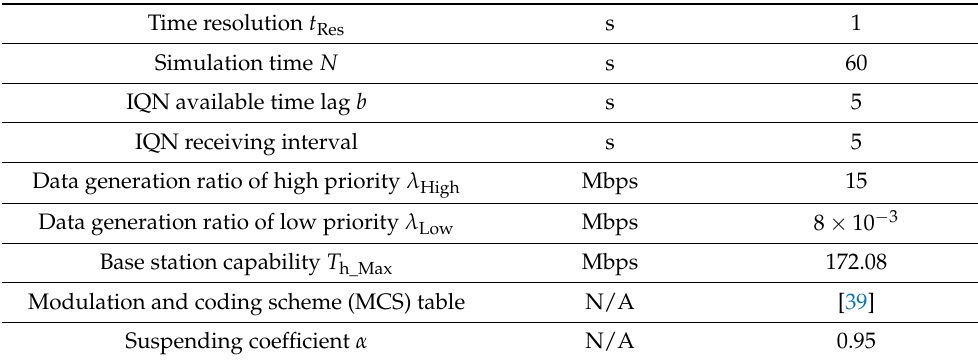
Table 3. Simulation parameters of IQN and data